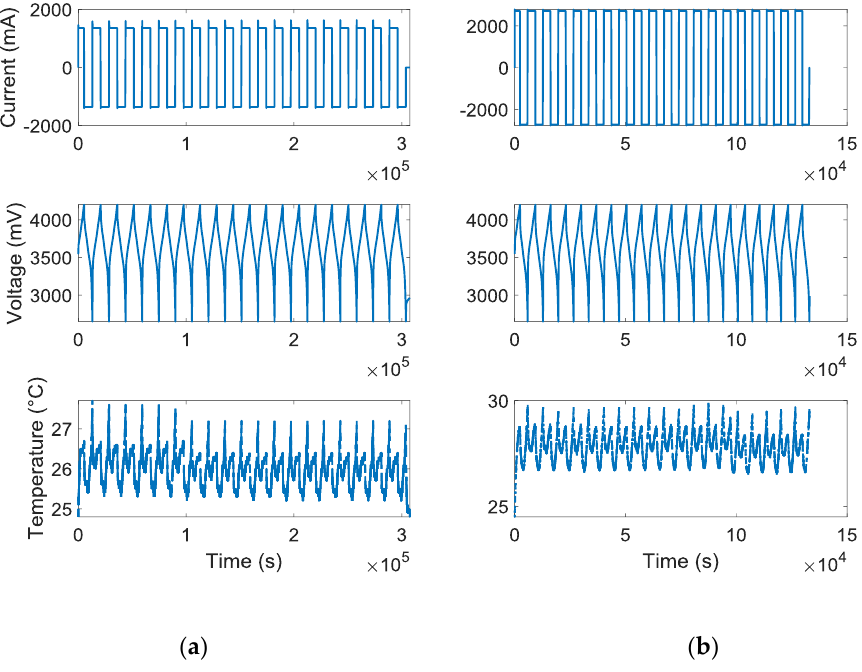
Figure 1. The load profile that was applied to the battery. ( a ) 0.4 C; ( b ) 0.8 C.